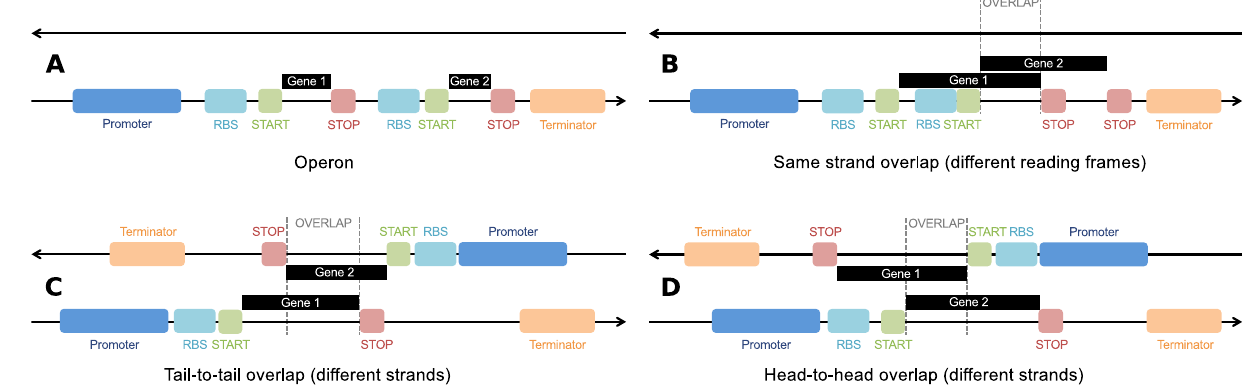
Figure 7. Examples of constrained genetic architecture in Aevol. (A) As is often the case in natural systems, here the two digital genes belong to the same operon. They share a promoter and a terminator sequence and are thus being expressed at the same level. These hypothetical genes would belong to the ‘‘operon only’’ category from Fig. 4 and Fig. 5. (B) These two genes also share the same operon but additionally their sequences overlap, putting them in the ‘‘operon and overlap’’ category. In this case, the genes are in different reading frames and do not share a STOP codon, although such configuration is also possible. As the black gene boxes indicate, the left STOP codon corresponds to the left START codon, while the right STOP codon corresponds to the right START codon. (C, D) Two examples of genes from the ‘‘overlap only’’ category which are encoded on different strands. This is not an exhaustive list of possible genetic constraints, as a gene may, for example, share an operon with a gene on the same strand while simultaneously overlapping with a gene on an opposite strand.